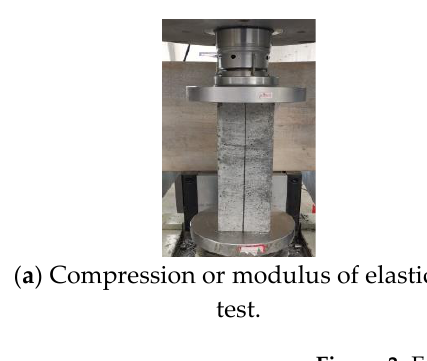
( d ) Elastic modulus. Figure 4. Mechanical characteristics of concrete with different LP contents. 3.2. Influence of Steel Fiber Contents and their Aspect Ratios on Mechanical Properties Figure 5 shows the effect of GSF0325 steel fiber contents on the mechanical charac- teristics of C80 concrete prepared with 10% of LP and the same fiber with a length-to- diameter ratio of 83. According to the experimental results, when the volume fraction for steel fiber increases, the axial compressive and flexural properties of concrete increase; however, its splitting tensile and modulus of elasticity first increase and then decrease.